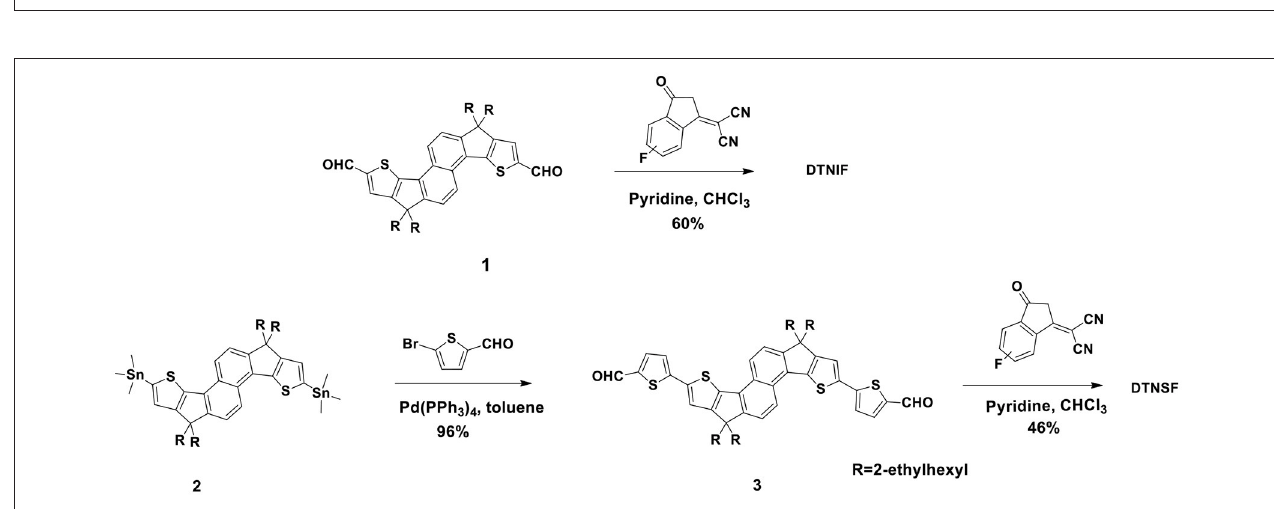
FIGURE 1 | Chemical structures of PBDB-T and the target non-fullerene acceptors.